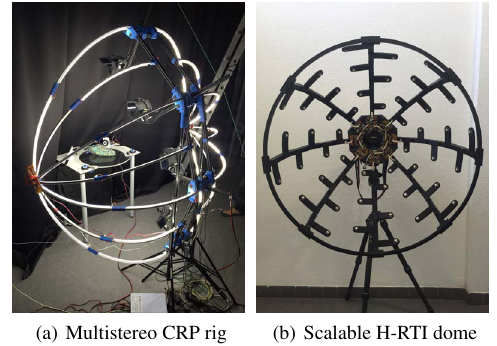
Figure 3: Examples of low-cost 3D printed prototype hardware acquisition systems realized by E. Gattet.